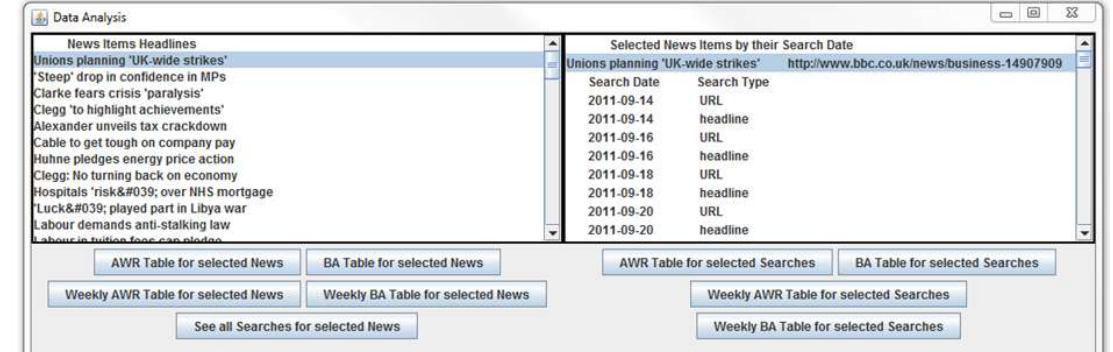
Figure 4: News Story Tracking